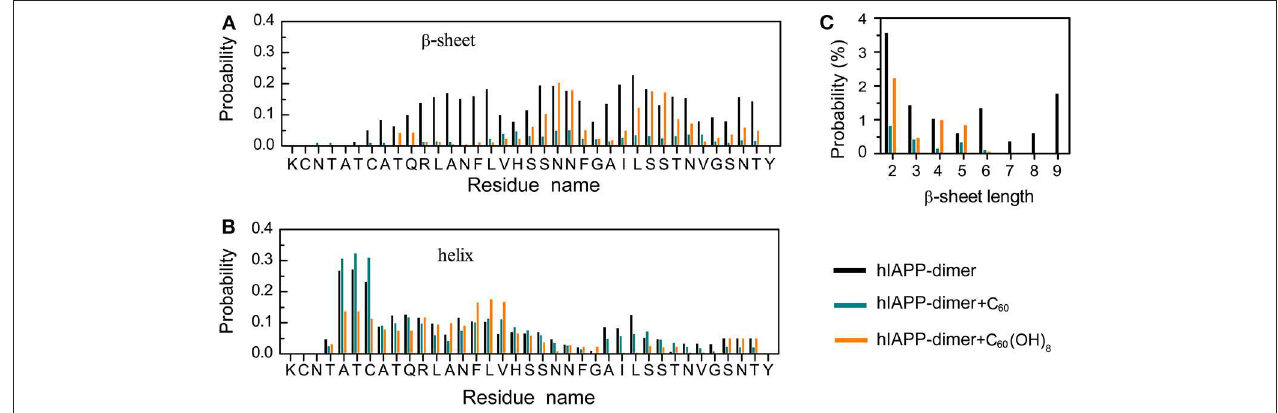
FIGURE 1 | Influence of C 60 and C 60 (OH) 8 on the secondary structures of hIAPP dimer. Probabilities of β -sheet (A) and coil (B) as a function of amino acid residue. (C) The probability distribution of β -sheet